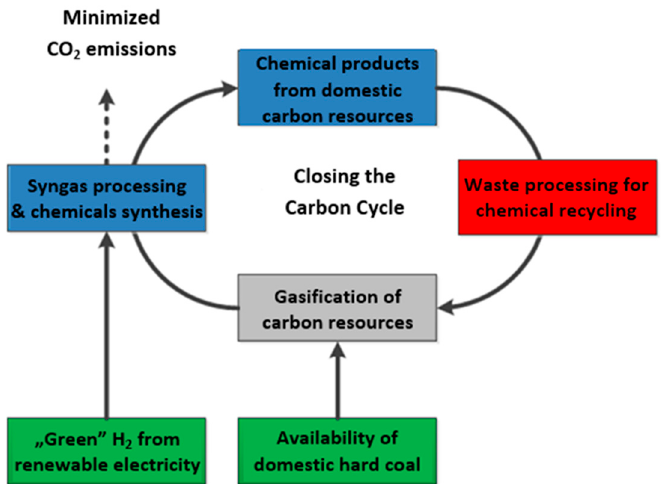
Figure 1. Transformation from a linear to circular carbon economy and closing the carbon cycle